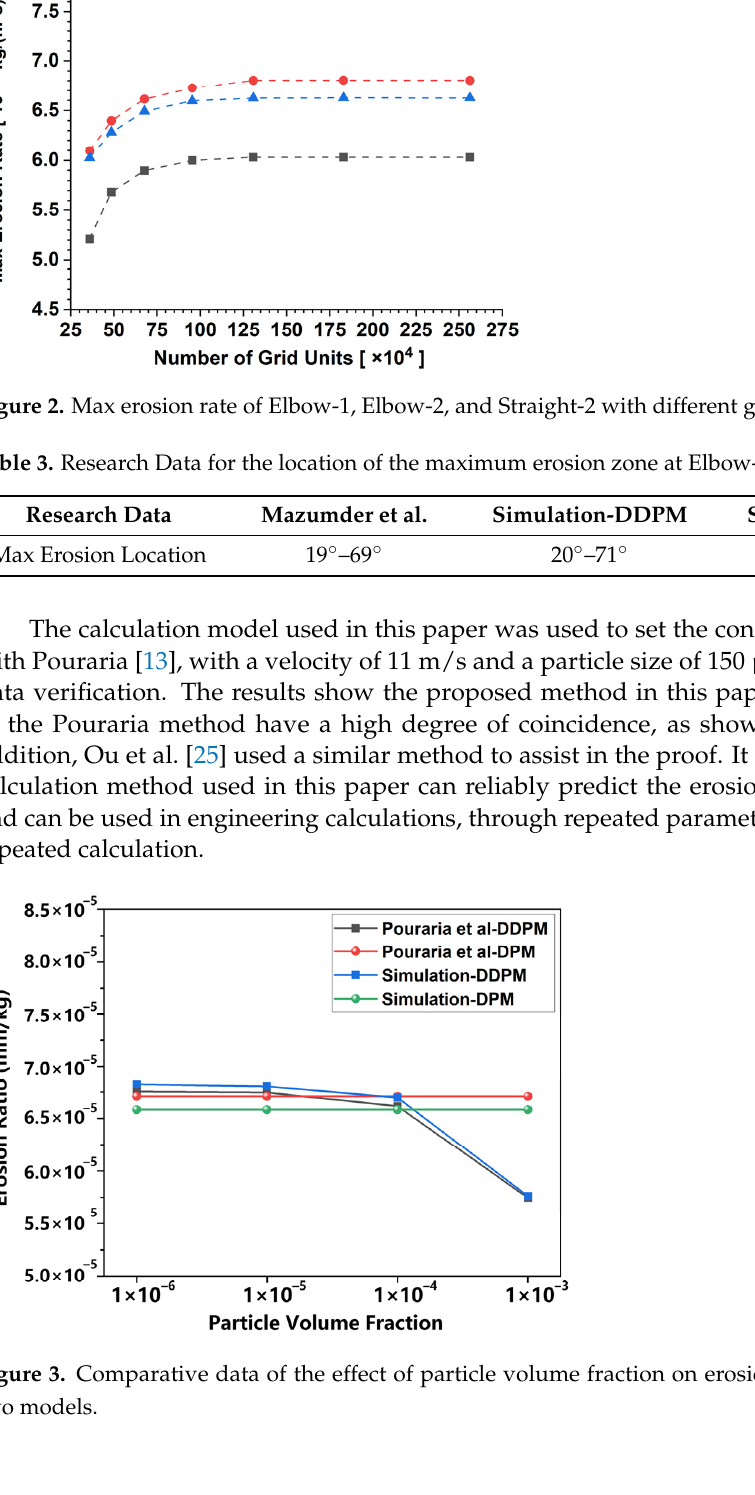
Table 3. Research Data for the location of the maximum erosion zone at Elbow-1.